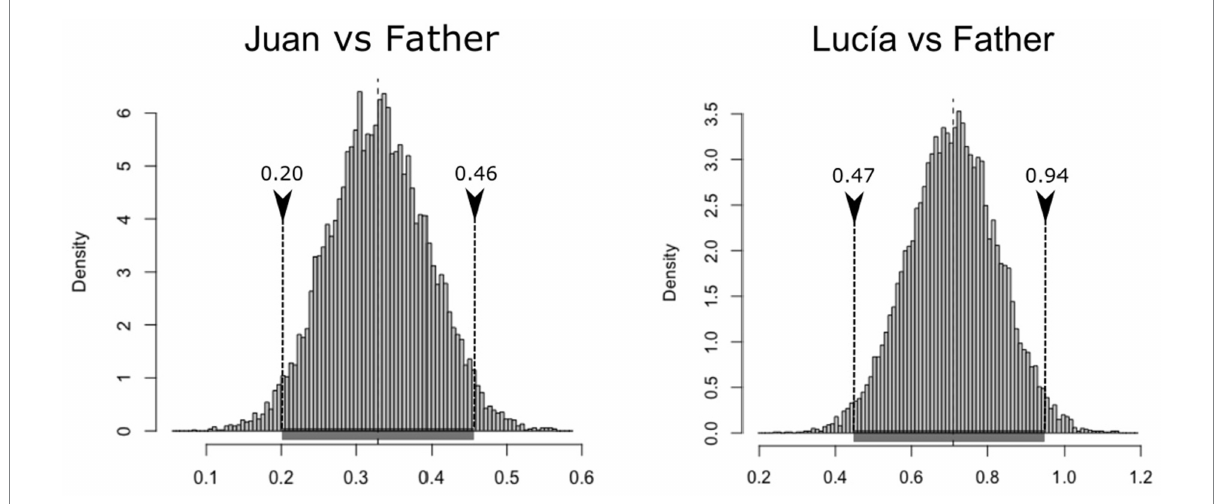
FIGURE 2 Histogram of the bootstrapped replicates of the differences in inflections per verb between the parental and child speech in Spanish.